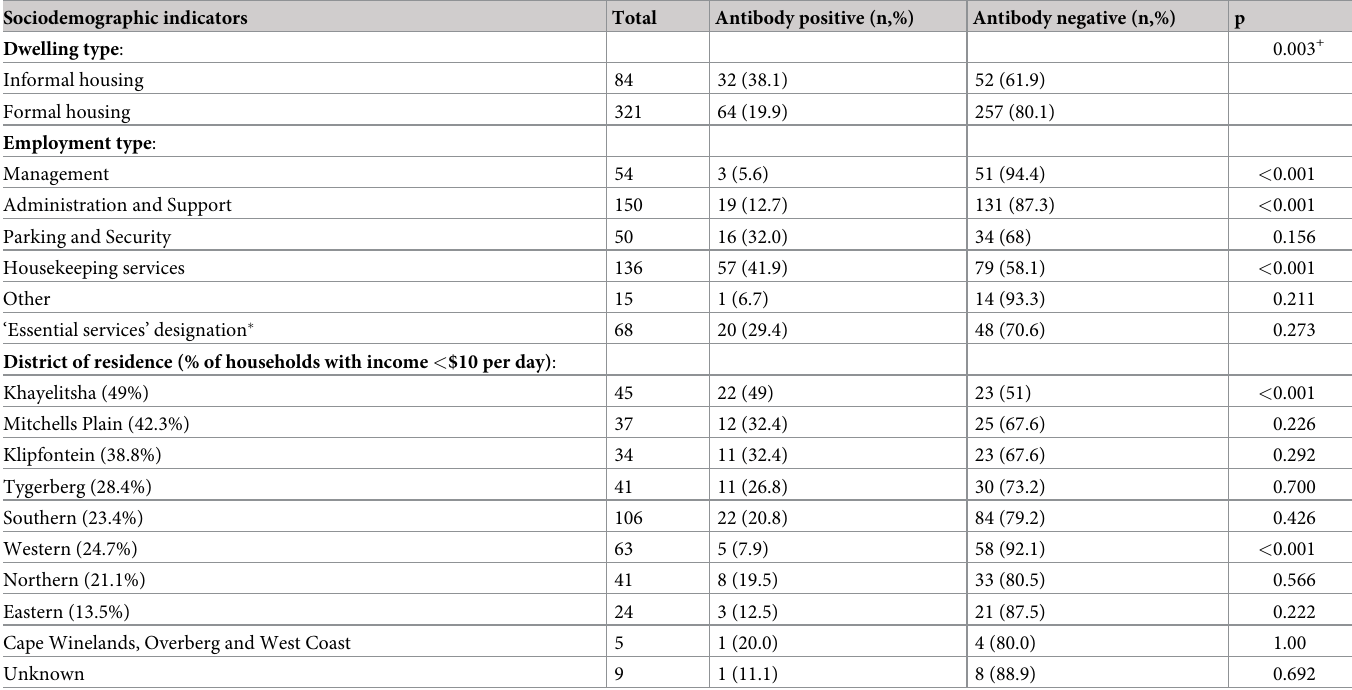
Table 2. SARS-CoV-2 seroprevalence and sociodemographic